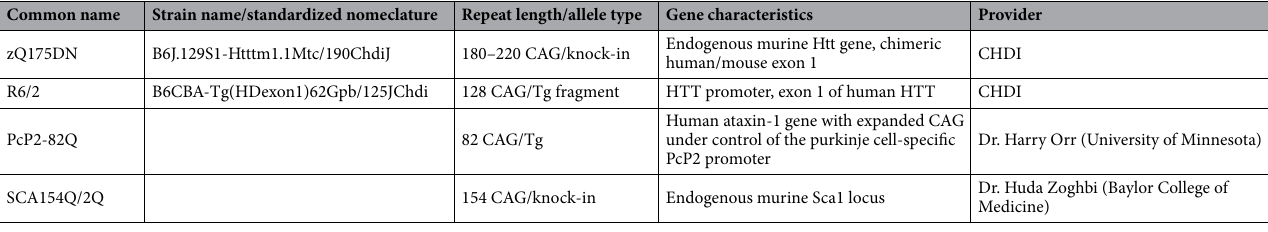
Protein aggregation. For N-terminal tag cleavage, proteins at 30 µM in 2 mL reaction tubes were incu-